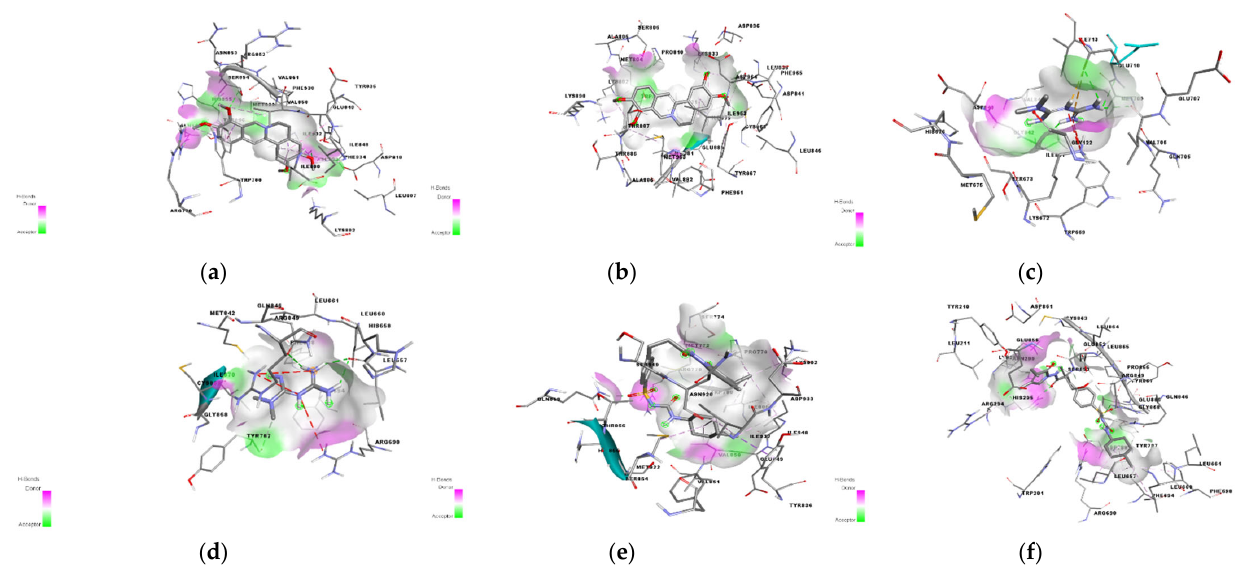
Figure 5. The structural binding interaction of ( a ) palmatine with PI3K alpha and ( b ) with PI3K gamma, ( c ) metformin with PI3K alpha and ( d ) PI3K gamma, and ( e ) glimepiride with PI3K alpha and ( f ) PI3K gamma. Table 2. The binding energy of the drugs with PI3K Gamma and PI3K Alpha .